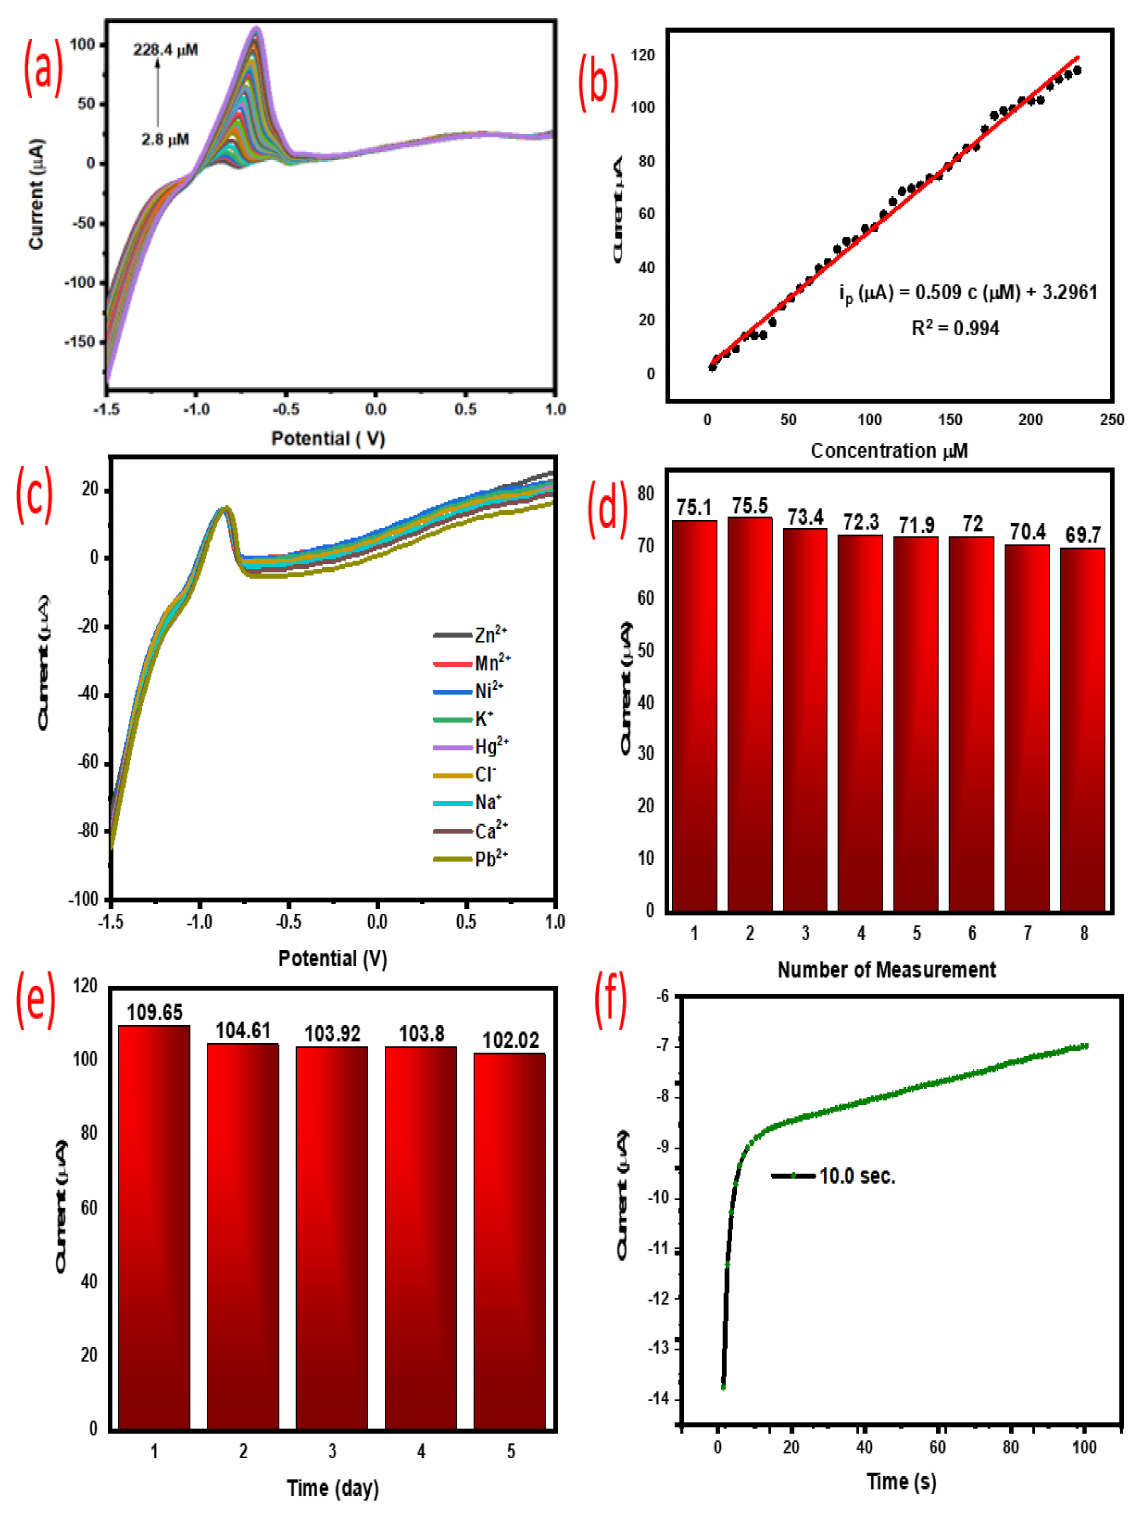
Figure 9. ( a ) LSV response of PANI@Al-SA/nafion modified GCE with different concentrations of Zn 2+ at a scan rate of 100 mV/s. ( b ) Calibration plot the peak current against Zn 2+ concentration. ( c ) Voltammetric response of PANI@Al-SA/nafion modified GCE in 0.02 mM Zn 2+ with addition of interferents (2-fold concentration) at scan rate 100 mV/s. ( d ) Given peak currents of PANI@Al-SA/nafion modified GCE in 0.14 mM Zn 2+ recorded at eight consecutive measurements. ( e )